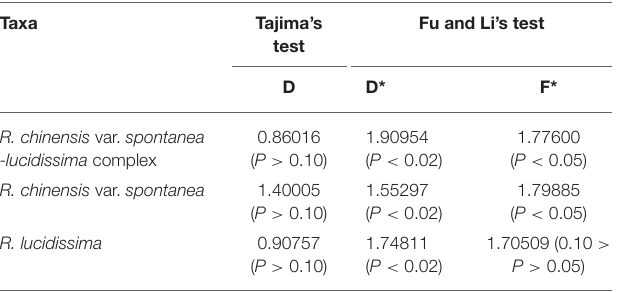
TABLE 4 | The results of Tajima’s test and Fu and Li’s test of R. chinensis var. spontanea-lucidissima complex and each taxon.